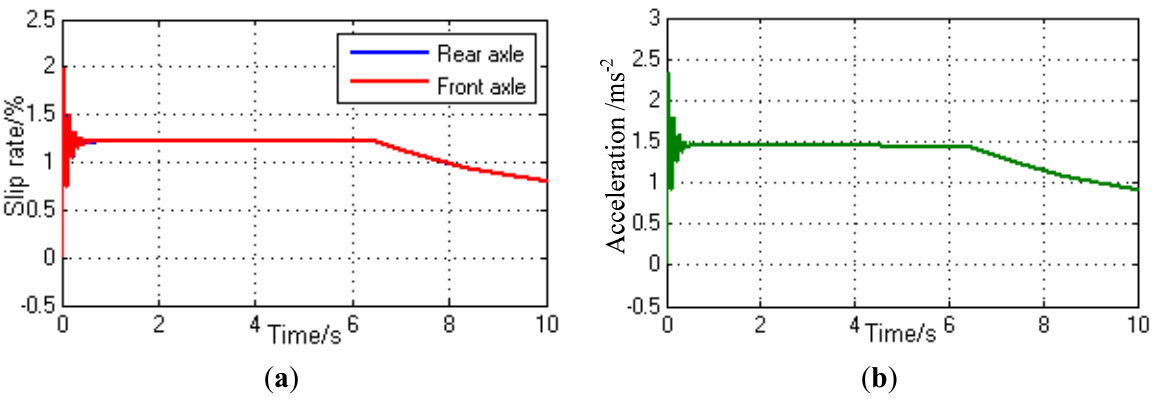
Figure 6. Simulation results of torque distribution by axle load on good roads: ( a ) The front and rear axle tyre slip rate; ( b ) Vehicle